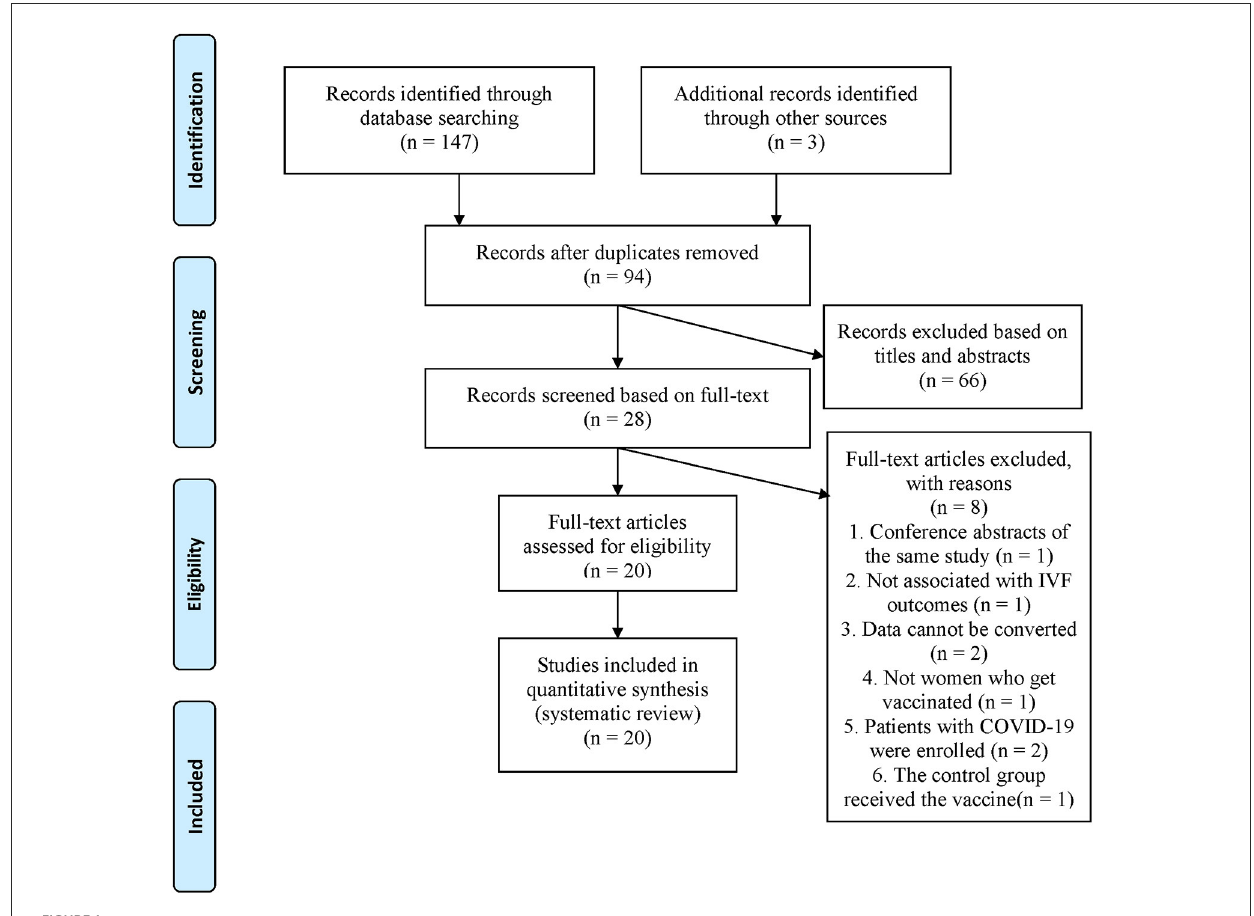
FIGURE1 PRISMA flow diagram.